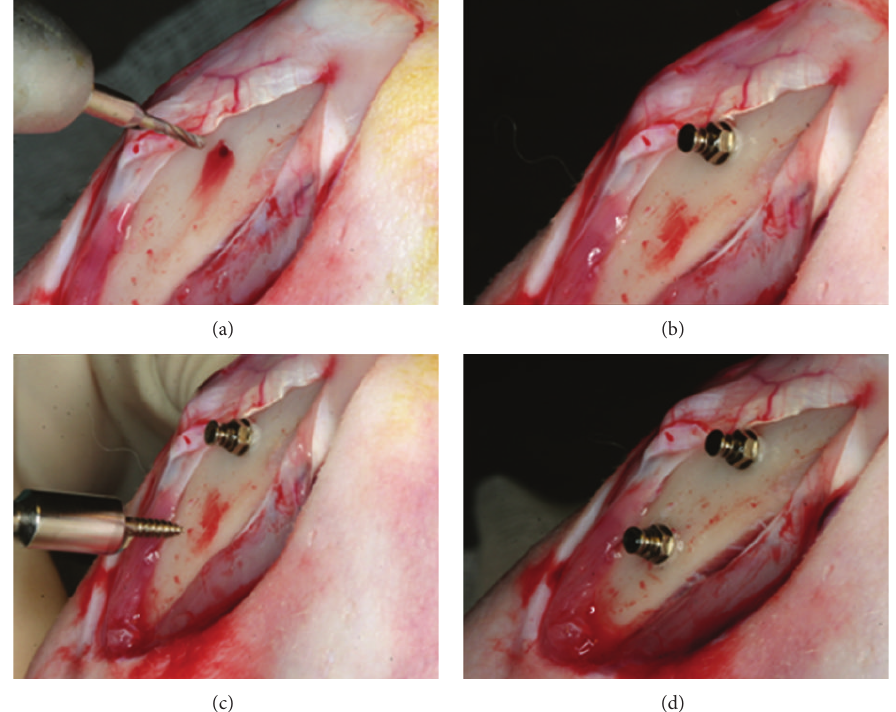
Figure 2: Orthodontic mini-implants implanted in rabbit tibia. (a) Predrilling for the self-tapping mini-implant was perfomed. (b) Self- tapping mini-implant was placed into the hole. (c), (d) Self-drilling mini-implant was placed into the bone without predrilling.